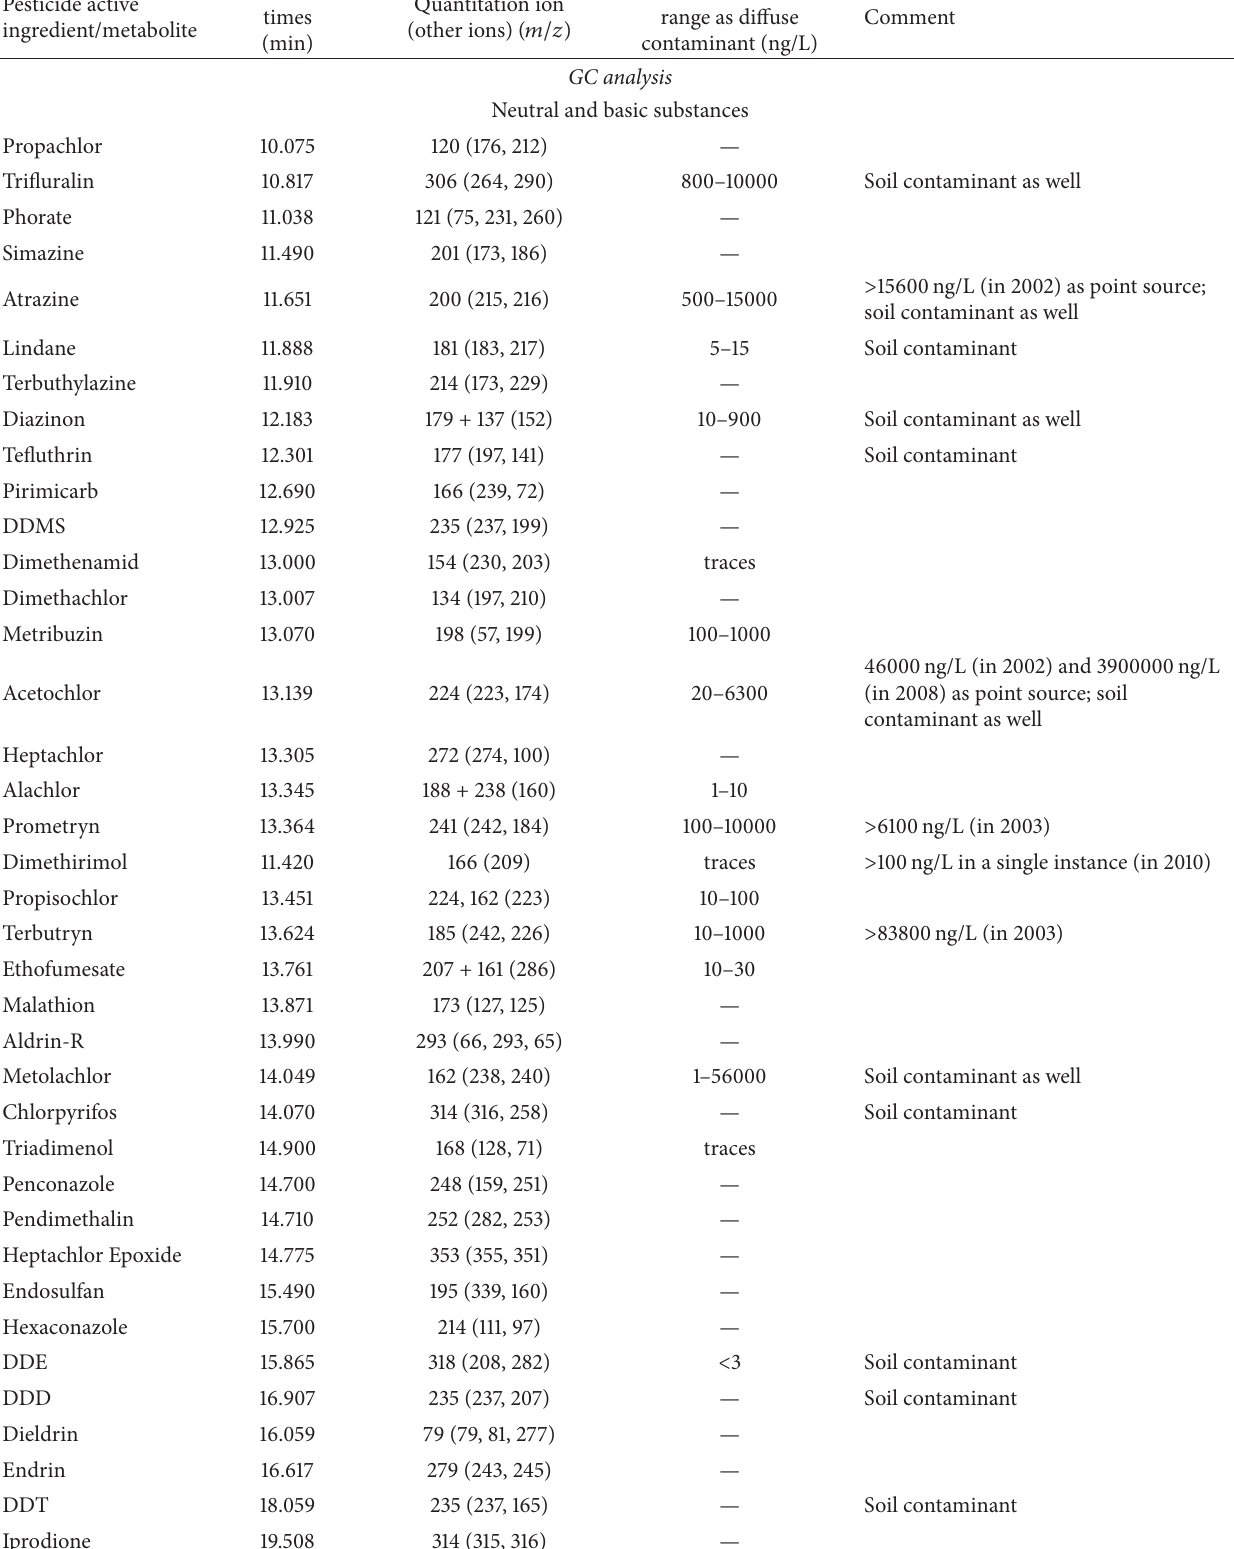
Table 1: Target compounds, their chromatographic retention time, and characteristic molecule ions for MS identification and concentrations found in surface water